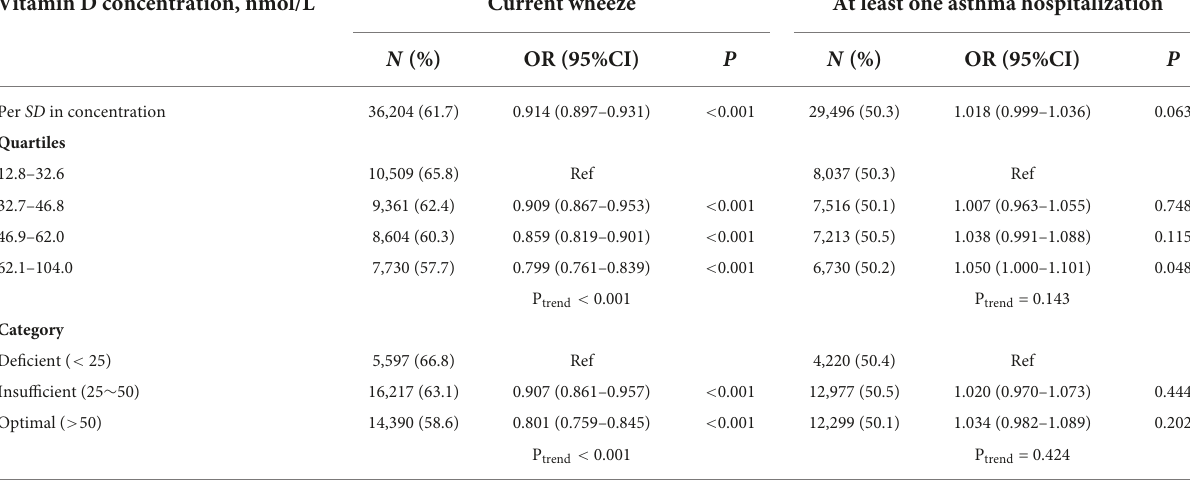
TABLE 4 Association of vitamin D concentrations with risk of wheeze and hospitalization among asthma patients. Vitamin D concentration,